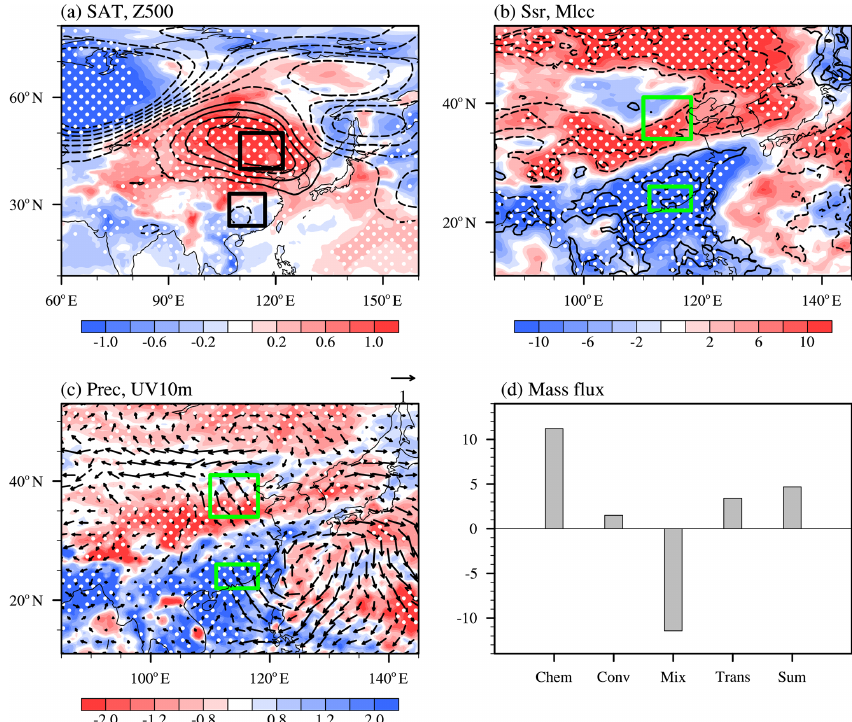
Figure 3. Composite summer atmospheric circulations associated with the DP-O 3 (DP-O 3 P minus DP-O 3 N) for the period 1980 to 2019, including (a) surface air temperature (SAT, unit: K, shadings) and geopotential height at 500hPa (unit: 10gpm, contours), (b) surface incoming shortwave flux (Ssr, unit: Wm − 2 , shadings) and low and medium cloud cover (Mlcc, unit: 1, contours), and (c) precipitation (Prec, unit: mm, shadings) and surface wind (unit: ms − 1 , arrows). The white dots indicate that the composites with shading were above the 90% confidence level. The black boxes in (a) indicate the centers of the AC NC and C PRD , respectively. The green boxes in (b) and (c) represent the areas of NC and the PRD. Composites of the summer mass fluxes of O 3 (d) associated with the DP-O 3 (DP-O 3 P minus DP-O 3 N) for the area-averaged differences (NC minus PRD) from 1980 to 2019. The bottom axis gives the names of the chemical and physical processes: chemical reaction (Chem), convection (Conv), PBL mixing (Mix), transport (Trans), and their sum